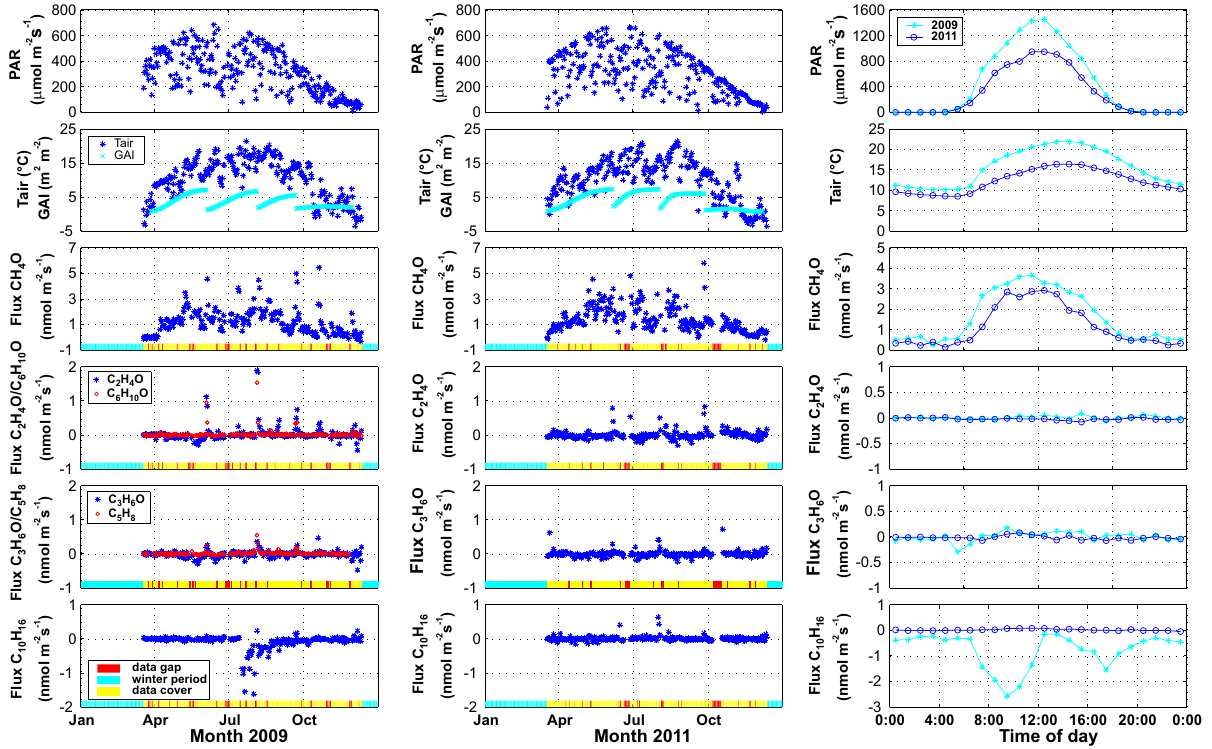
Fig. 1. Time series of daily averages of photosynthetically active radiation (PAR), air temperature (Tair), the green area index (GAI) and VOC fluxes for the years 2009 (left column) and 2011 (centre column) and average diurnal cycles for the same variables and a selected time period (18 July–1 August) in the summers of 2009 and 2011 (right column). The winter period (cyan), data gaps (red) and data cover (yellow) for the different VOCs are earmarked as horizontal bars at the bottom of each time